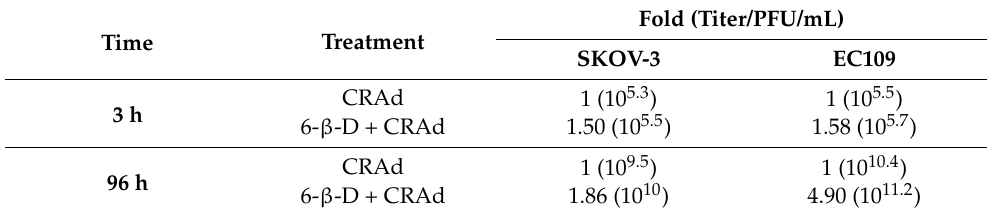
Table 1. Viral titer of CRAd detected by TCID 50 .